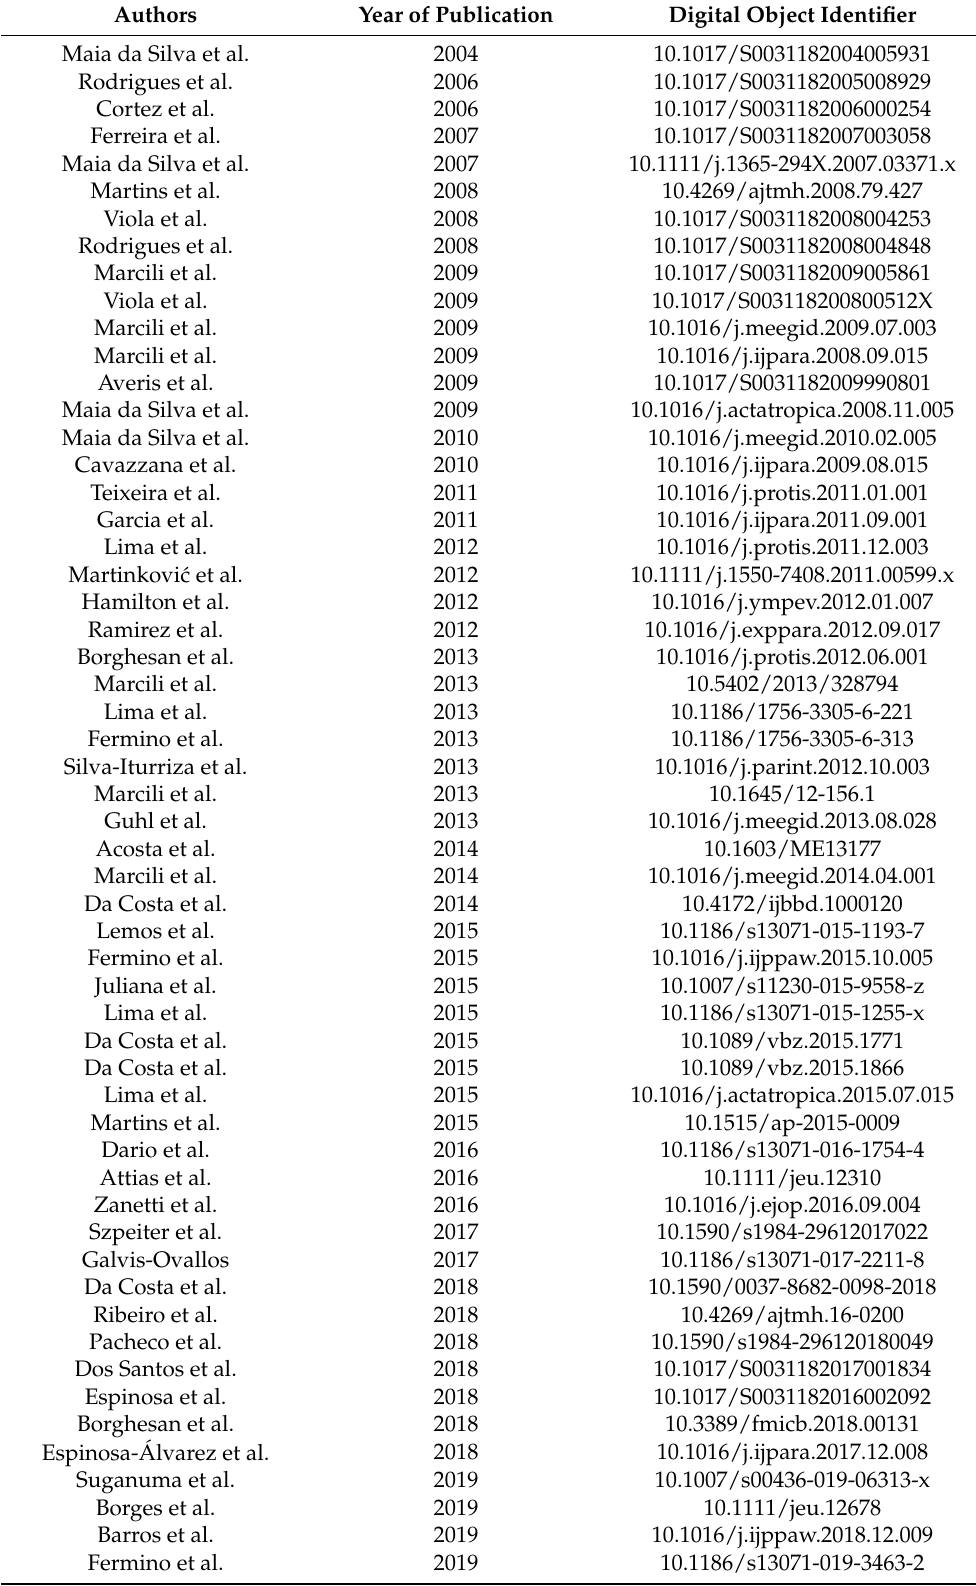
Table 1. List of all papers referring to the variable region V4 as the V7/V8 regions of trypanosomes. These papers investigate the diversity of trypanosome species and their phylogenetic